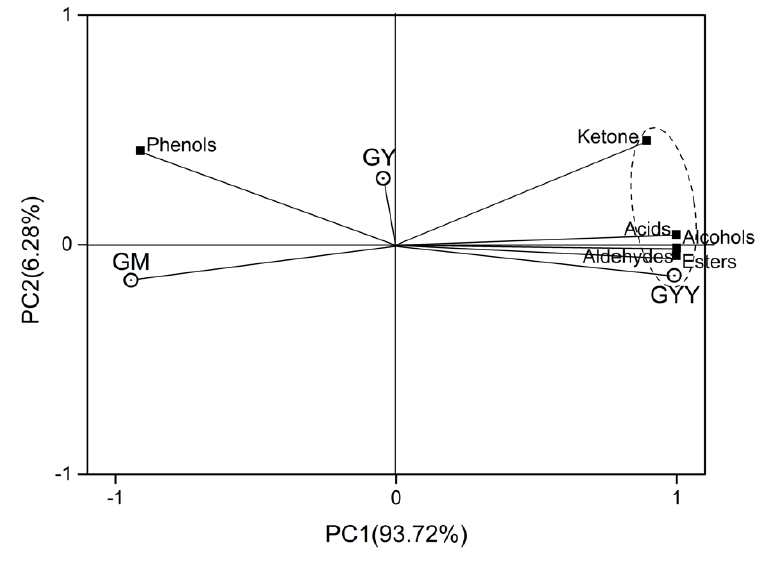
Figure 6. Principal component analysis of different types of volatiles detected by GC ‐ MS from goat milk samples.